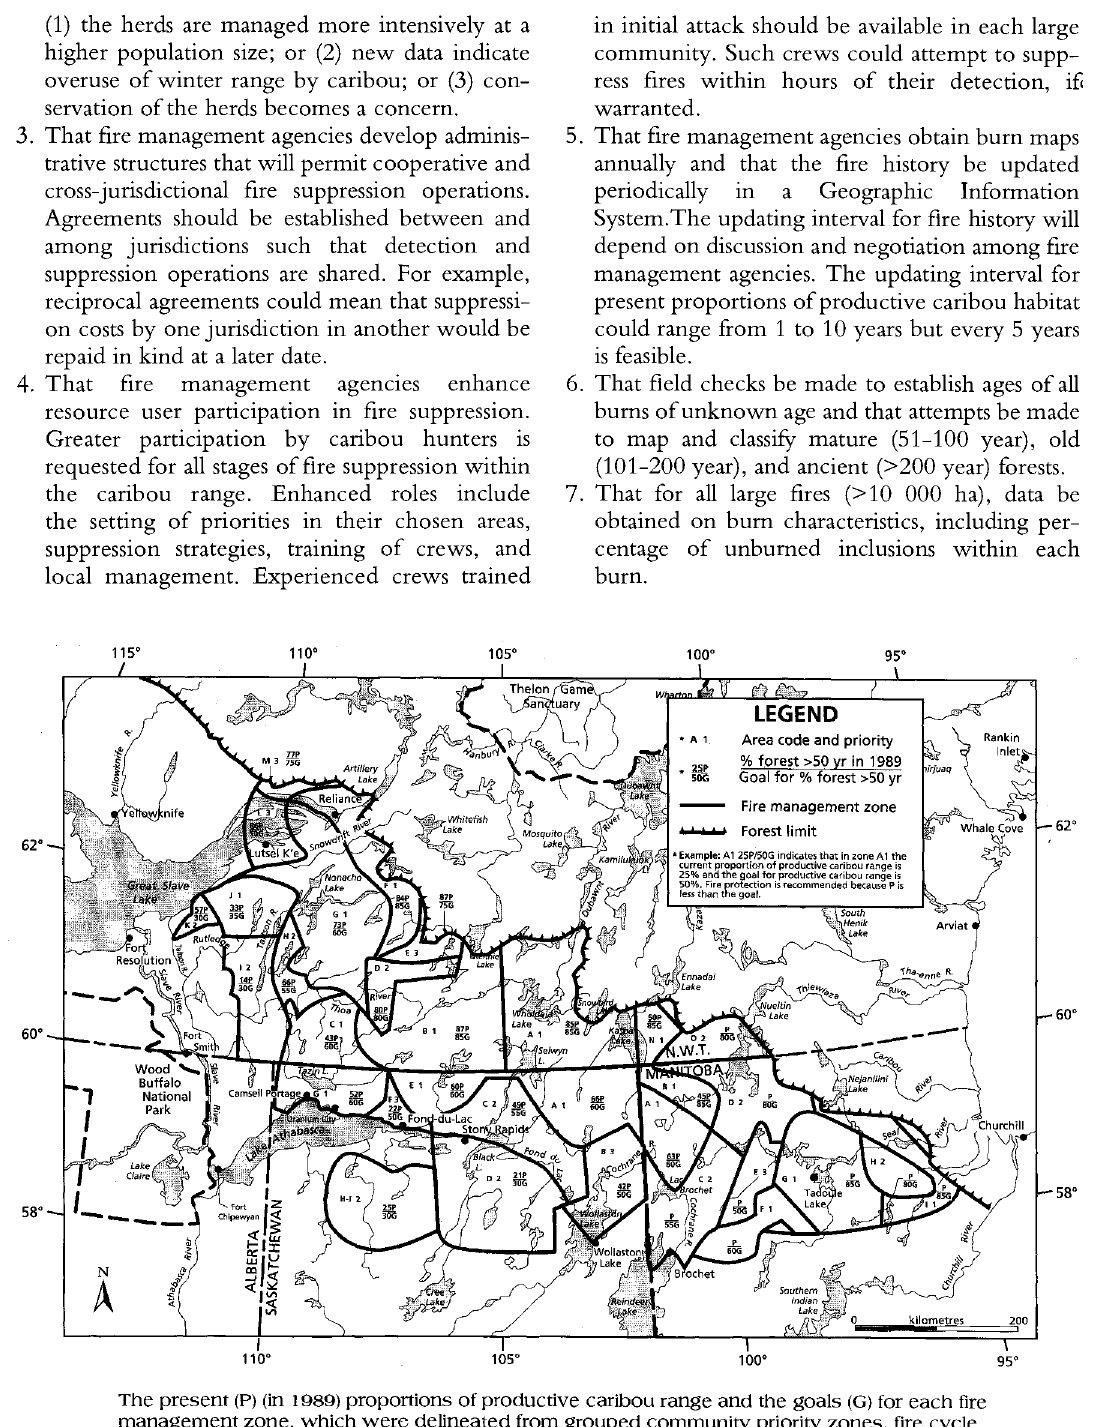
Fig. 3. Coded (A, B, etc.) simplified fire management areas based on composite priority (1, 2, etc.) areas of communities, fire cycle lengths, jurisdictional boundaries, forest limits; each containing preliminary estimates percent of produc tive (P) (>50 year forests) caribou habitat in 1989, and preliminary goals (G) for productive caribou